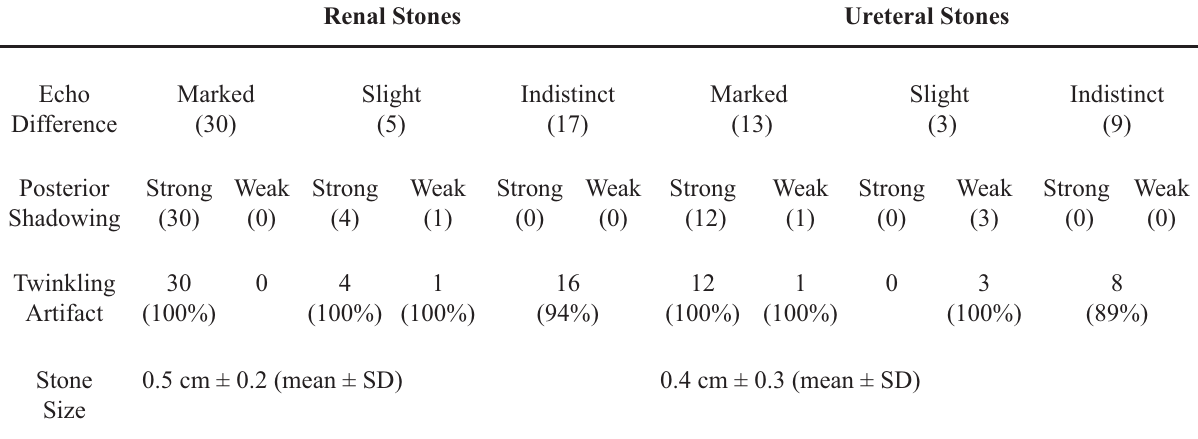
Table 2 – Comparison of gray-scale ultrasound and Doppler twinkling artifacts of urinary stones. Renal